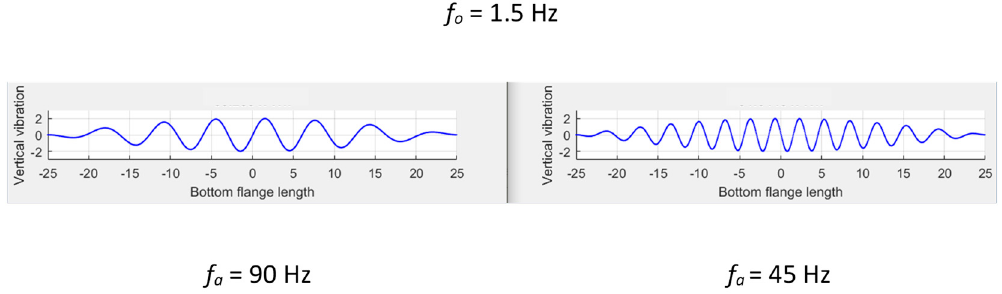
Figure 9. Angular Distance vs. Angular Frequency.